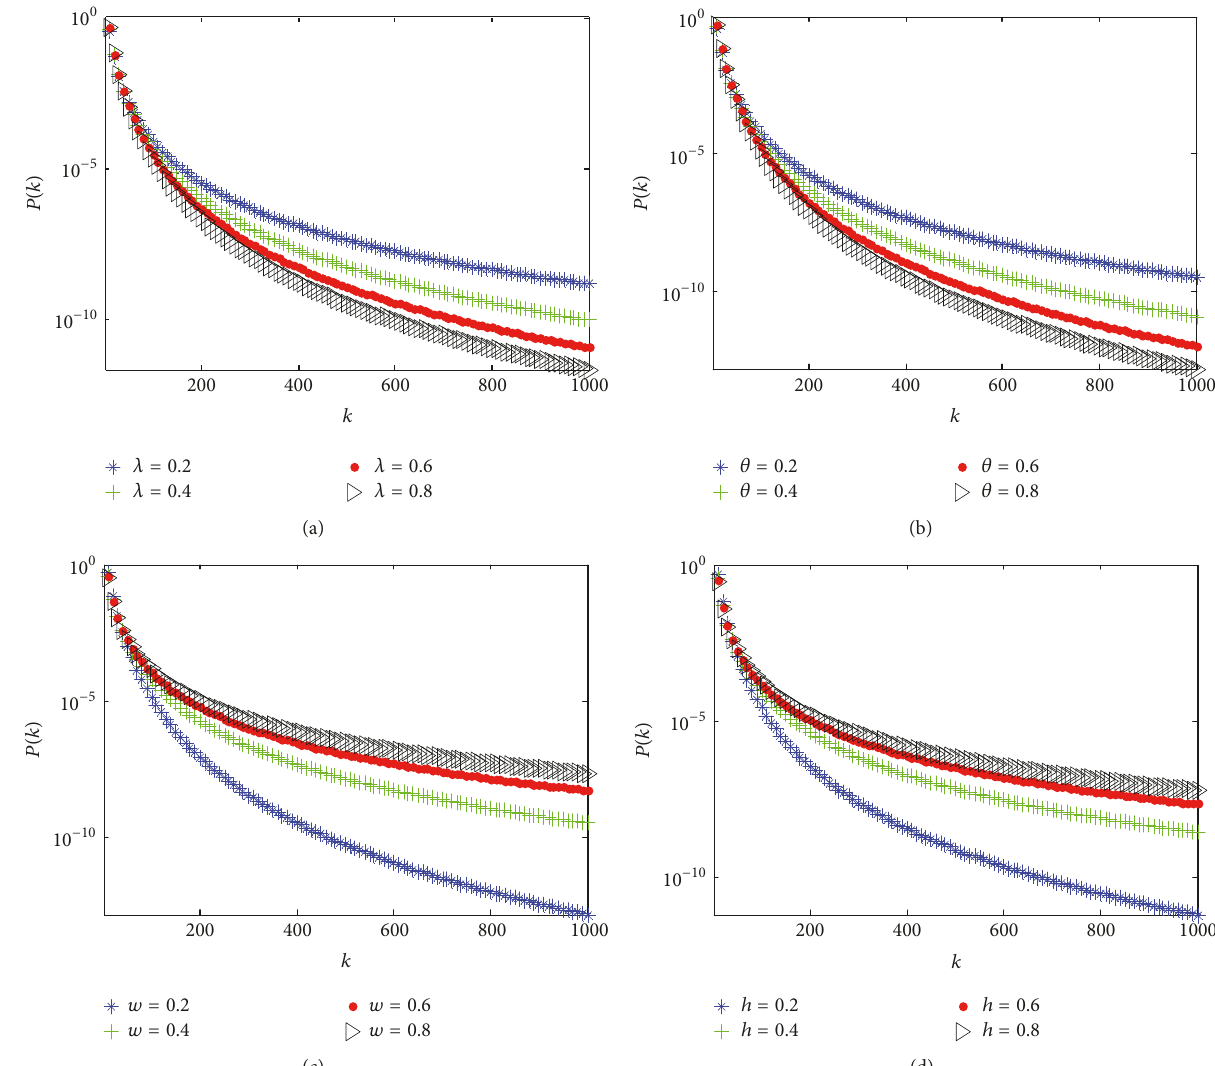
Figure 3: Effect of information transparency on the network topology characteristics of food safety scare behavior diffusion: (a) the network topology characteristics of food safety scare behavior diffusion when the rates of information dissemination are 𝜆 = 0.2 , 𝜆 = 0.4 , 𝜆 = 0.6 , and 𝜆 = 0.8 ; (b) the network topology characteristics of food safety scare behavior diffusion when consumer concerns about food safety incidents are 𝜃 = 0.2 , 𝜃 = 0.4 , 𝜃 = 0.6 , and 𝜃 = 0.8 ; (c) the network topology characteristics of food safety scare behavior diffusion when government food safety supervision information transparency is 𝑤 = 0.2 , 𝑤 = 0.4 , 𝑤 = 0.6 , and 𝑤 = 0.8 ; and (d) the network topology characteristics of food safety scare behavior diffusion when media food safety supervision information transparency is ℎ = 0.2 , ℎ = 0.4 , ℎ = 0.6 , and ℎ = 0.8